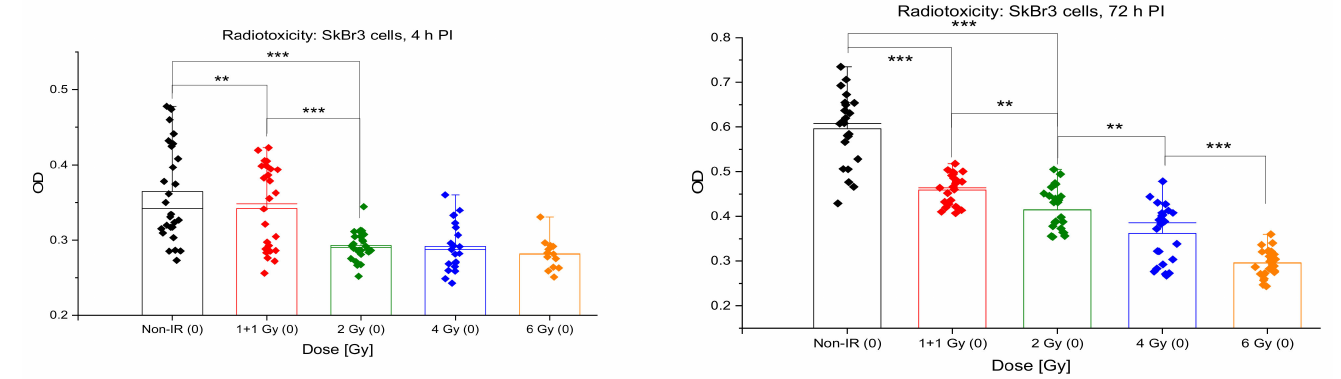
Figure 13. Effect of different γ -ray doses alone on SkBr3 cell viability as measured by MTT test. Dose- dependent survival is shown for 4 h ( left ) and 72 h PI ( right ), respectively. Four to six independent measurements for each irradiation dose are averaged and shown as the mean ± SD. Asterisks denote statistical significance of differences between indicated samples at p = 0.05 (*), p = 0.01 (**) or p = 0.001 (***). Two-tailed t -test, two-tailed t -test with Welsh correction or Mann–Whitney Rank Sum Test was used depending on the distribution normality of the analyzed variables.